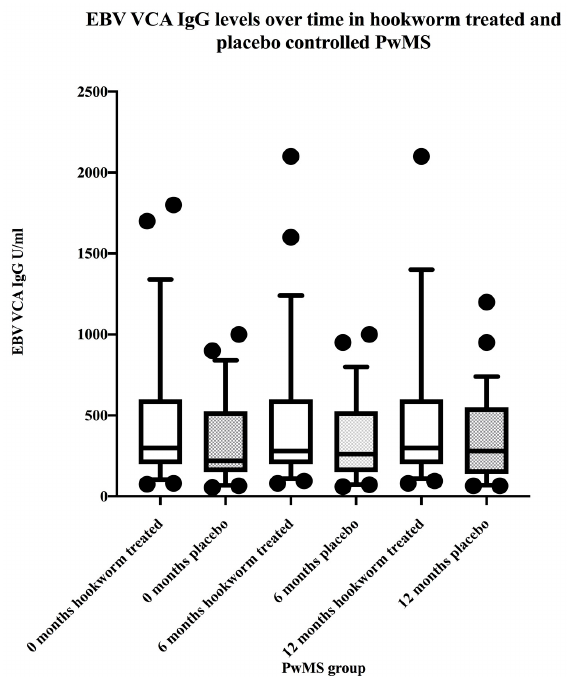
Figure 1. Data represent stability over 12 months of EBV VCA IgG levels in hookworm-treated and placebo-controlled PwMS. Box and whiskers plots comparing median and 10 th and 90 th percentile range with outliers of EBV VCA IgG levels in hookworm-treated (clear) versus placebo-controlled (shaded) PwMS before, during, and after treatments. Vaccines 2020 , 8 , x